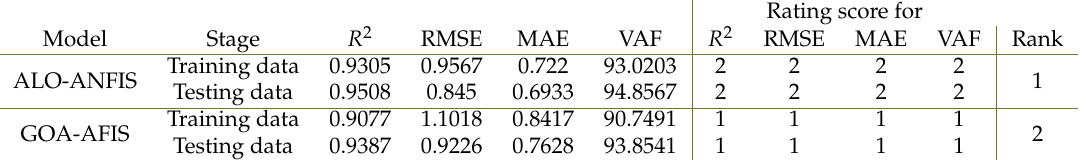
Table 2. obtained values of R 2 , RMSE, MAE, and VAF for developed ANFIS models